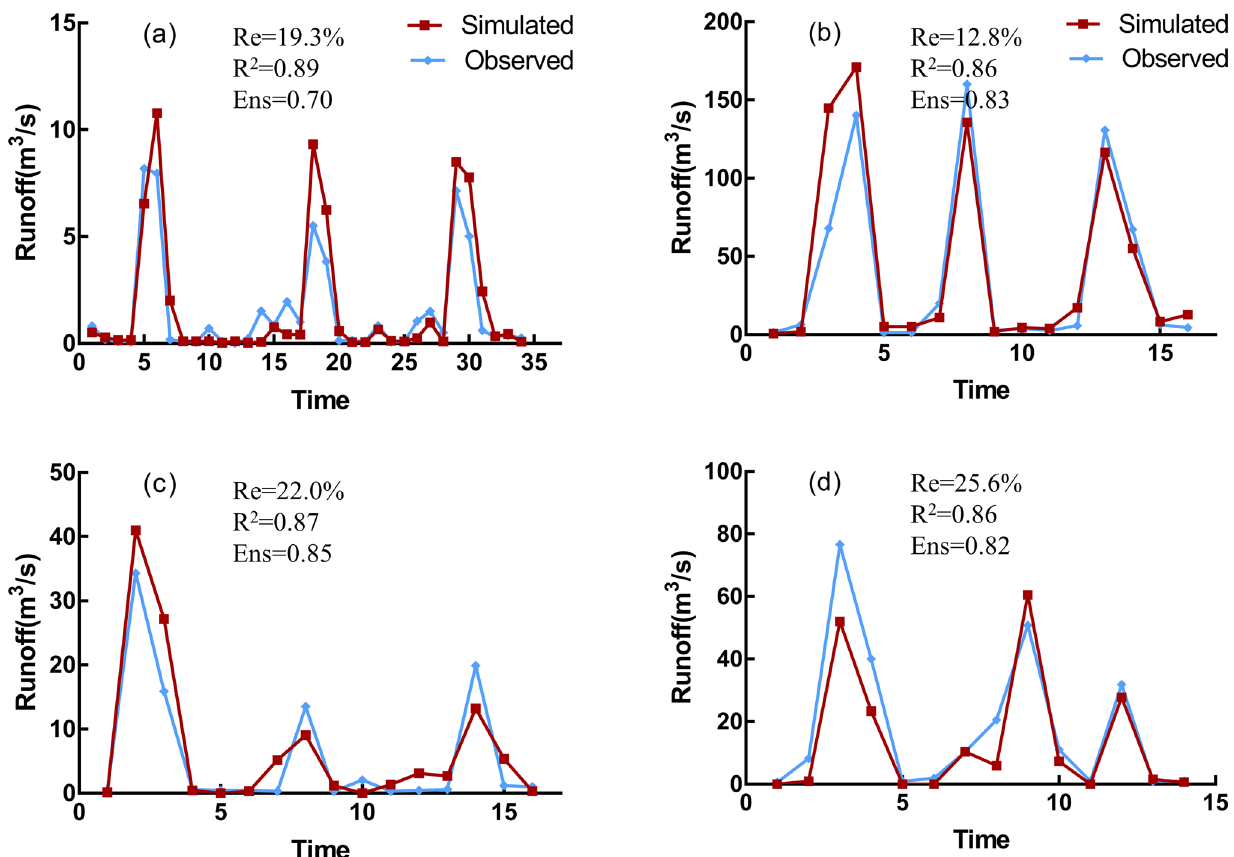
Fig. 3 Comparison of observed and simulated monthly runoff during calibration period at different stations: a Dongdingjia; b Zaochao; c Houlugezhuang; d